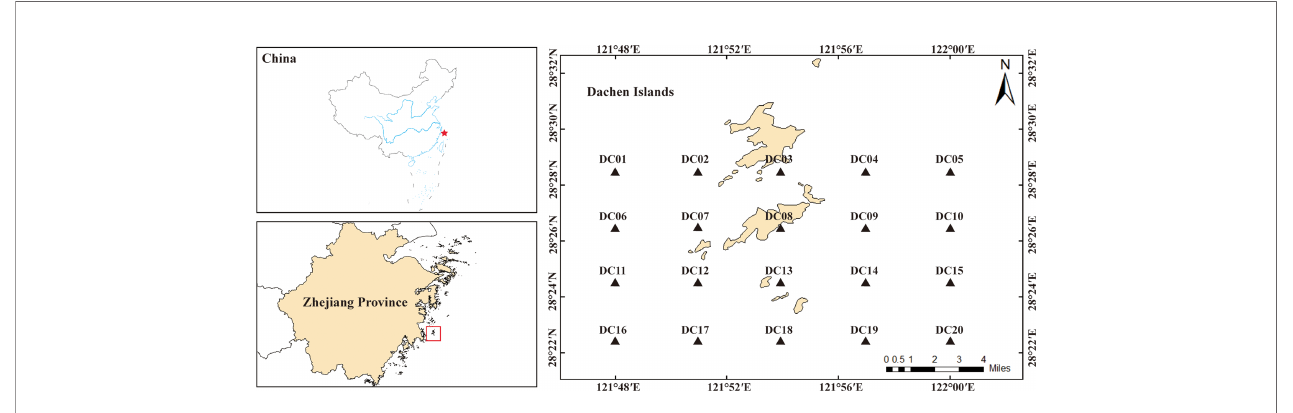
FIGURE 2 | Location of Dachen Islands with 20